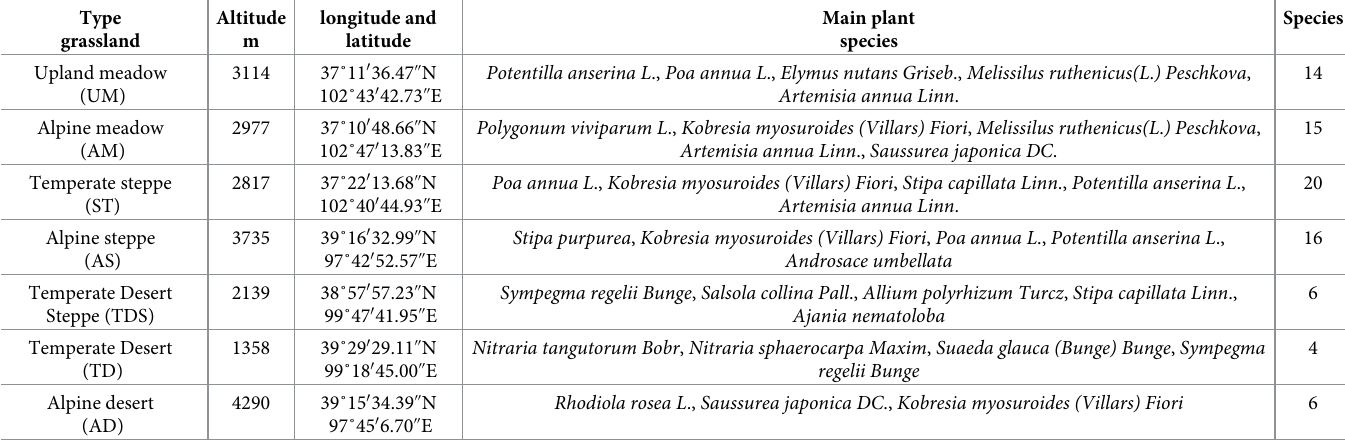
Table 1. Basic information of the sample